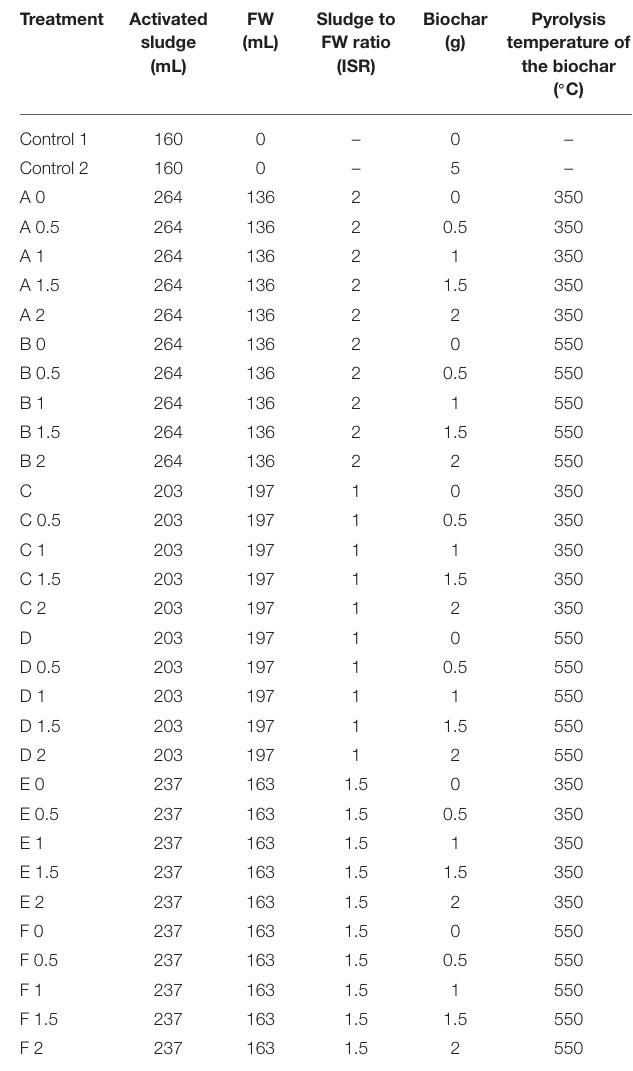
TABLE 2 | Experimental conditions used for anaerobic batch